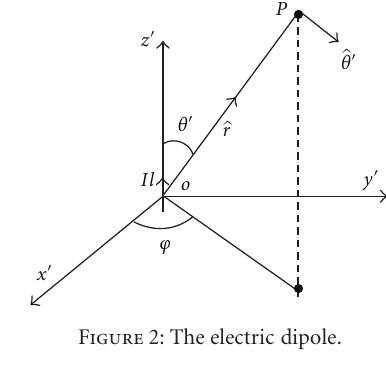
Figure 2: The electric dipole.